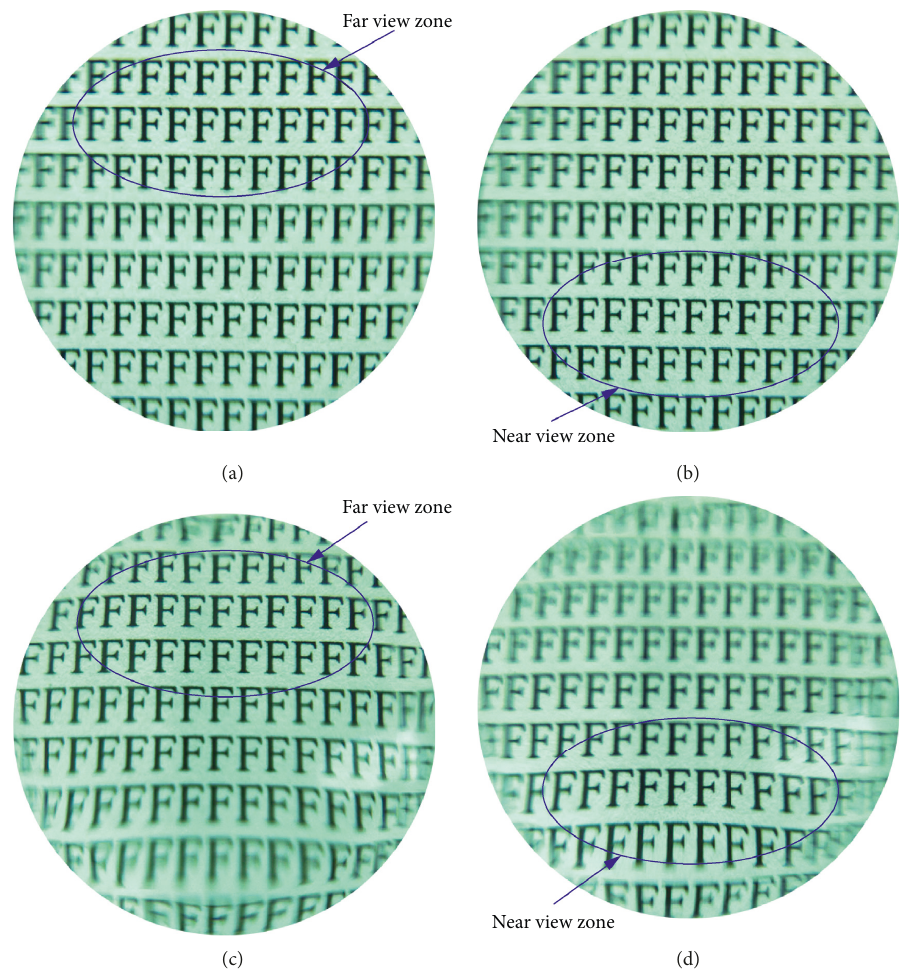
Figure 10: Test images of the F target for different focal lengths. (a) Focused image in the far view region ( f � 310mm). (b) Focused image in the near view region ( f � 280mm). (c) Focused image in the far view region ( f � 250 mm). (d) Focused image in the near view region ( f �